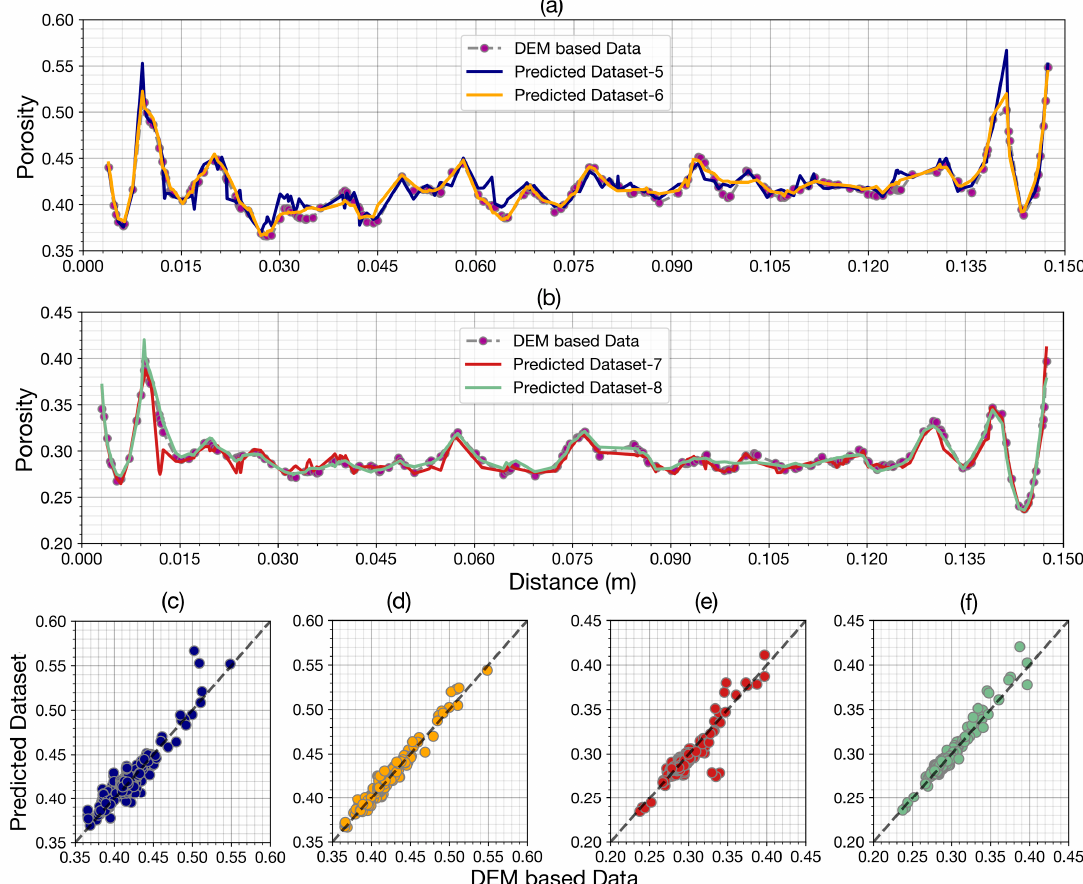
Figure 12. FNN predicted porosity along x-directio ( a ) Datasets 5 and 6, ( b ) Datasets 7 and 8, and Scatter plots ( c ) Dataset-5, ( d ) Dataset-6, ( e ) Dataset-7, and ( f ) Dataset-8. Table 6. Statistical performances of FNN model (for testing data) along the flume (x-direction).